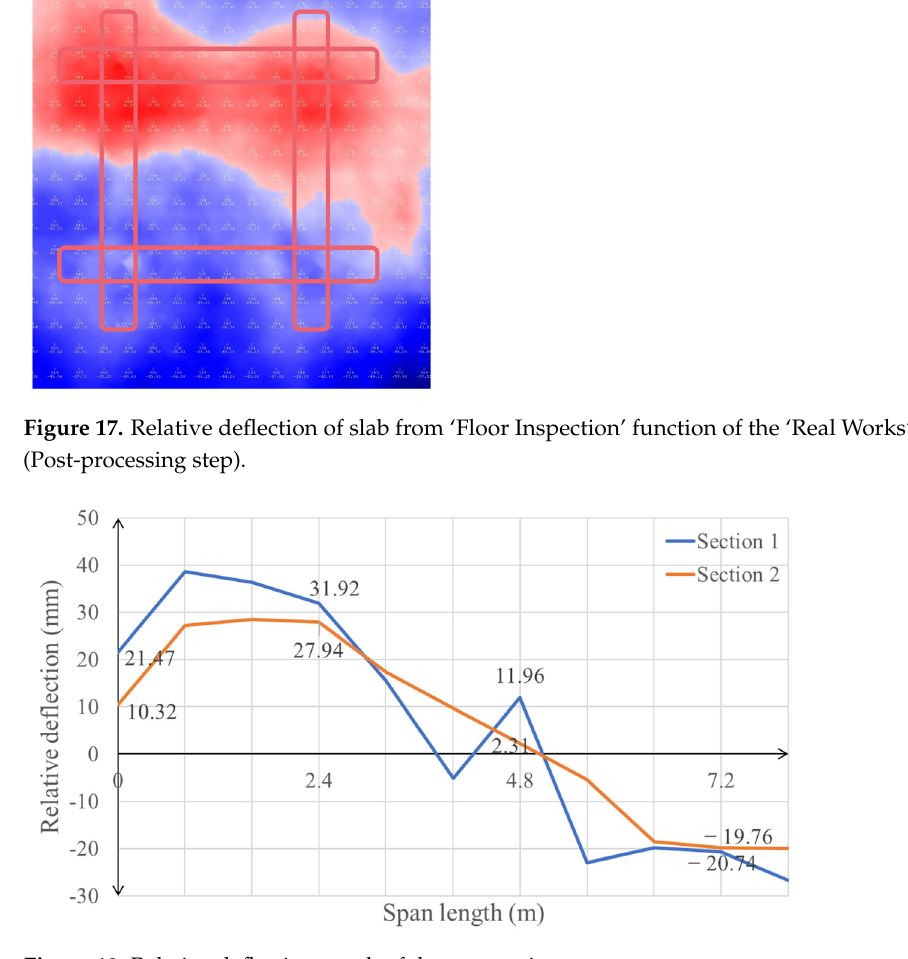
Table 6. Deflection value of each section (Campus building